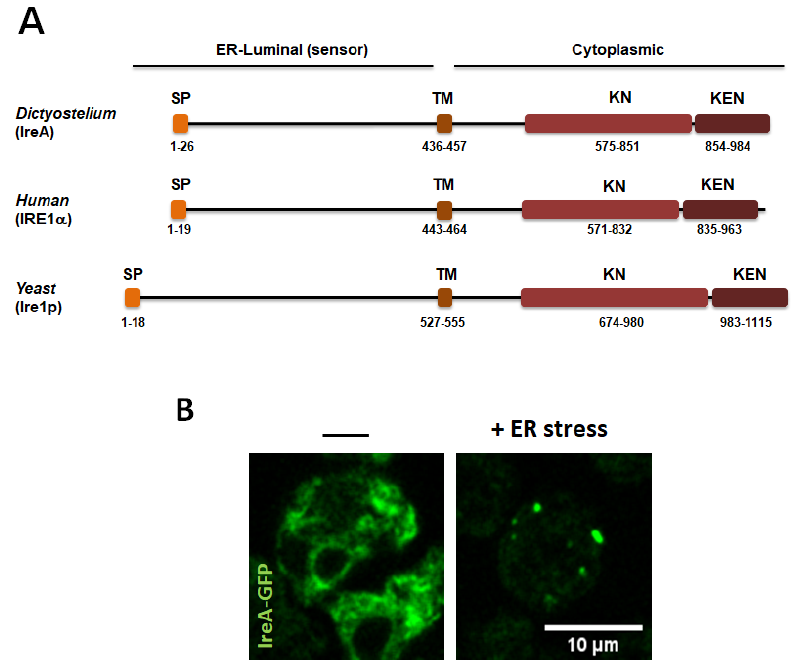
Figure 4. ( A ) Diagram of the structural domains of Dictyostelium IreA, compared with its Saccharomyces cerevisiae and human orthologs. SP (signal peptide), TM (transmembrane domain), KN (kinase domain), and KEN (kinase extension nuclease domain). Proteins were drawn to scale. Numbers indicate amino acid coordinates. Protein domains were obtained from www.uniprot.org. ( B ) Live-cell confocal microscopy of ireA − cells expressing the IreA-GFP construct after 4 h, in the absence or in the presence of an ER-stress inducer. The IreA-GFP signal forms large puncta (possibly high-order oligomers). (Scale bar corresponds to 10 µ